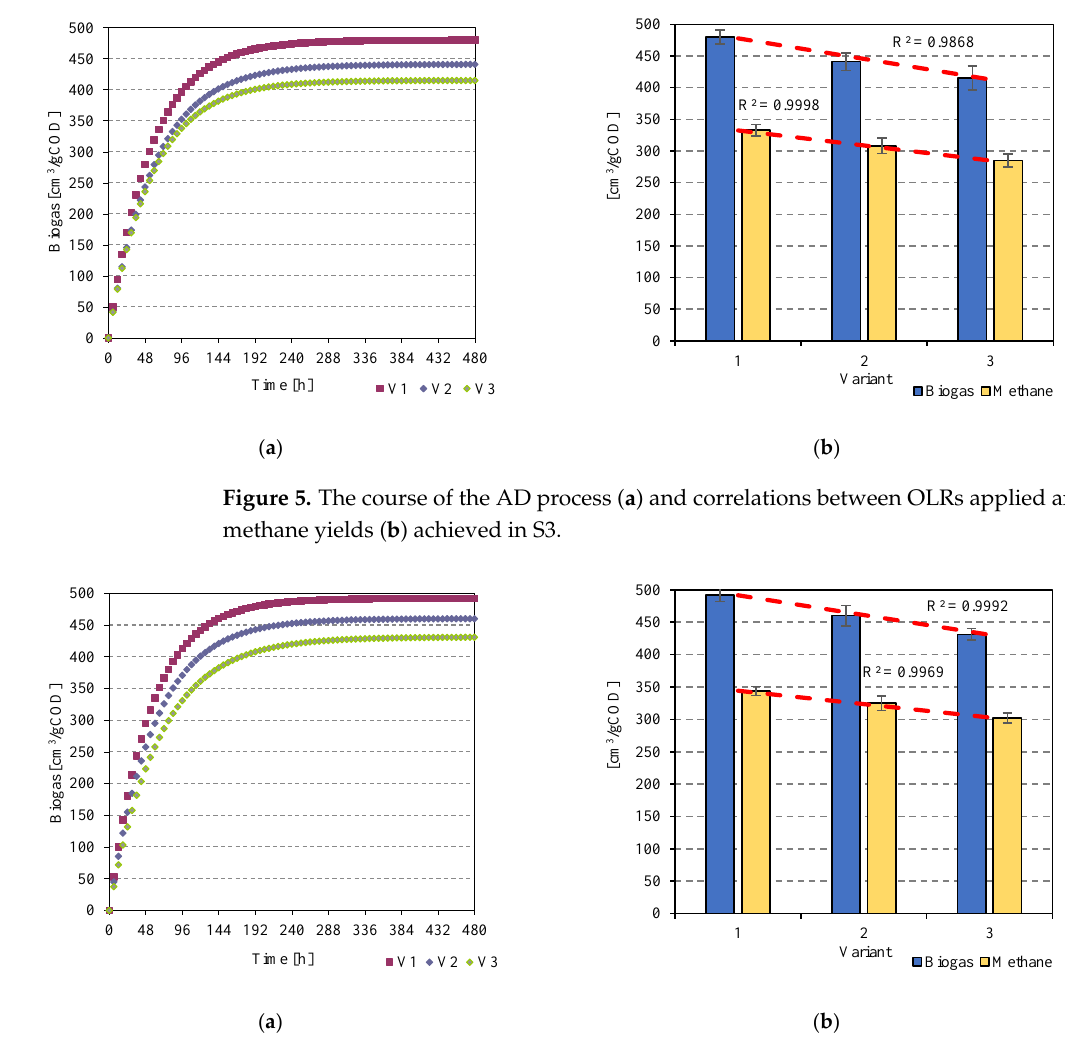
Figure 6. The course of the AD process ( a ) and correlations between OLRs applied and biogas and methane yields ( b ) achieved in S4. The study conducted by Erden et al. (2010) [35] aimed to evaluate the effect of low- frequency ultrasound pre-treatment (20 kHz) on the anaerobic biodegradation of meat processing effluent. Experiments were performed for 50 days for the effluents treated at three specific energy inputs, i.e., 2, 120, and 750 MJ/kgTS, and for the non-pre-treated ef-